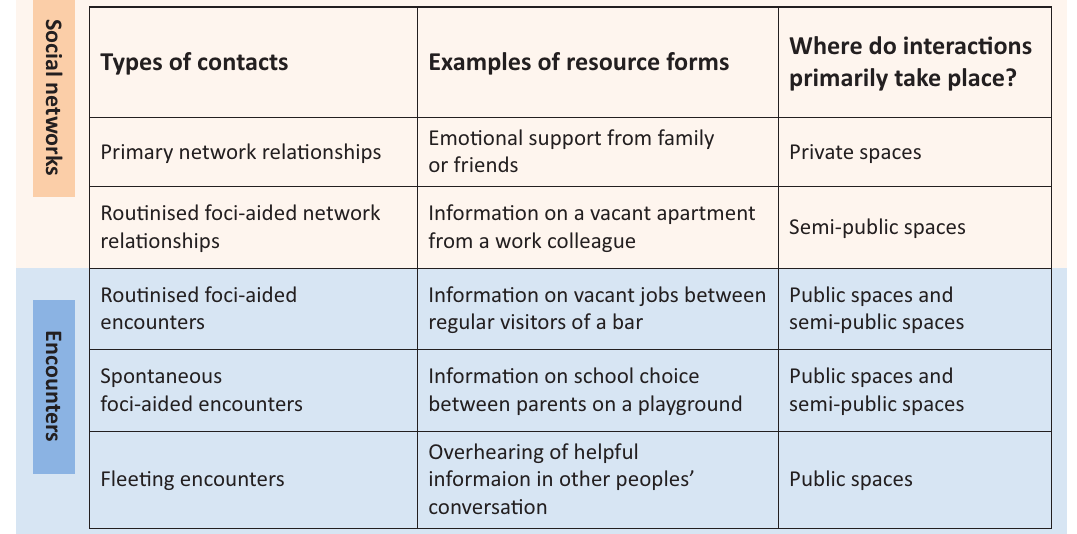
Figure 1. Types of contacts and resource access. Source: Own classification, based on Lofland